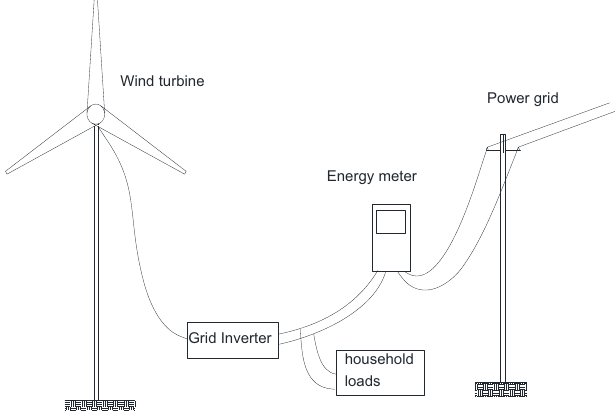
Fig. 1. Layout of on-grid wind